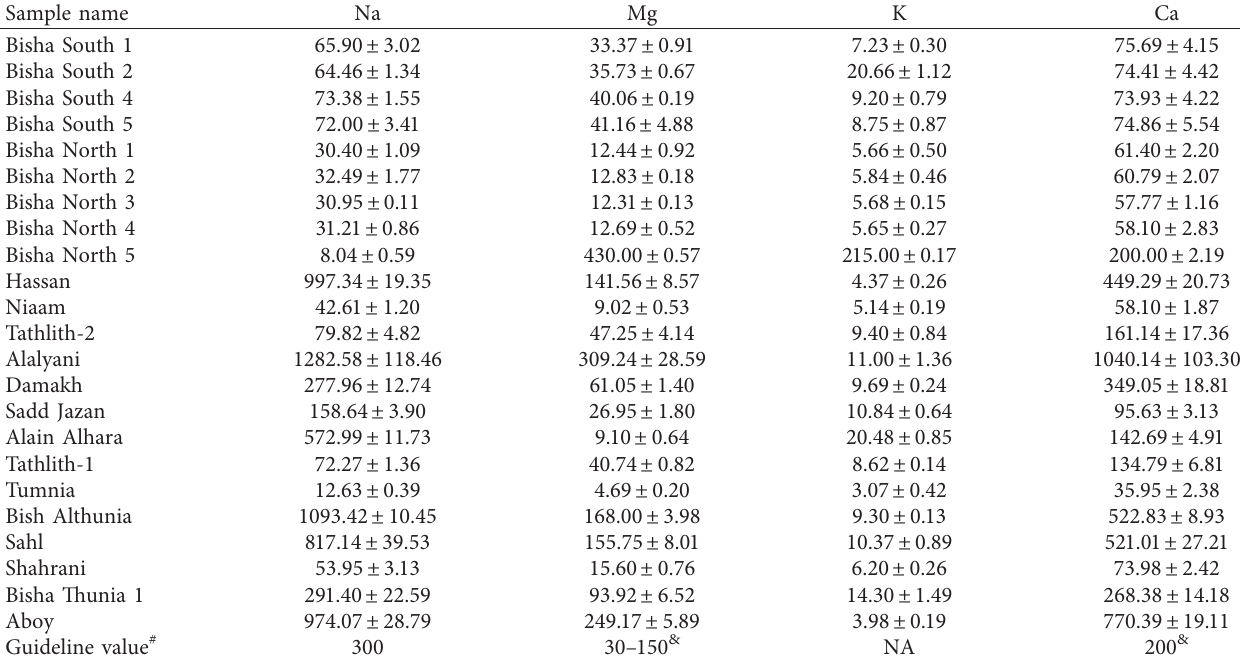
Table 2: Concentrations (mg/L) of the major elements mean ± SD ( n � 3), in 23 ∗ groundwater